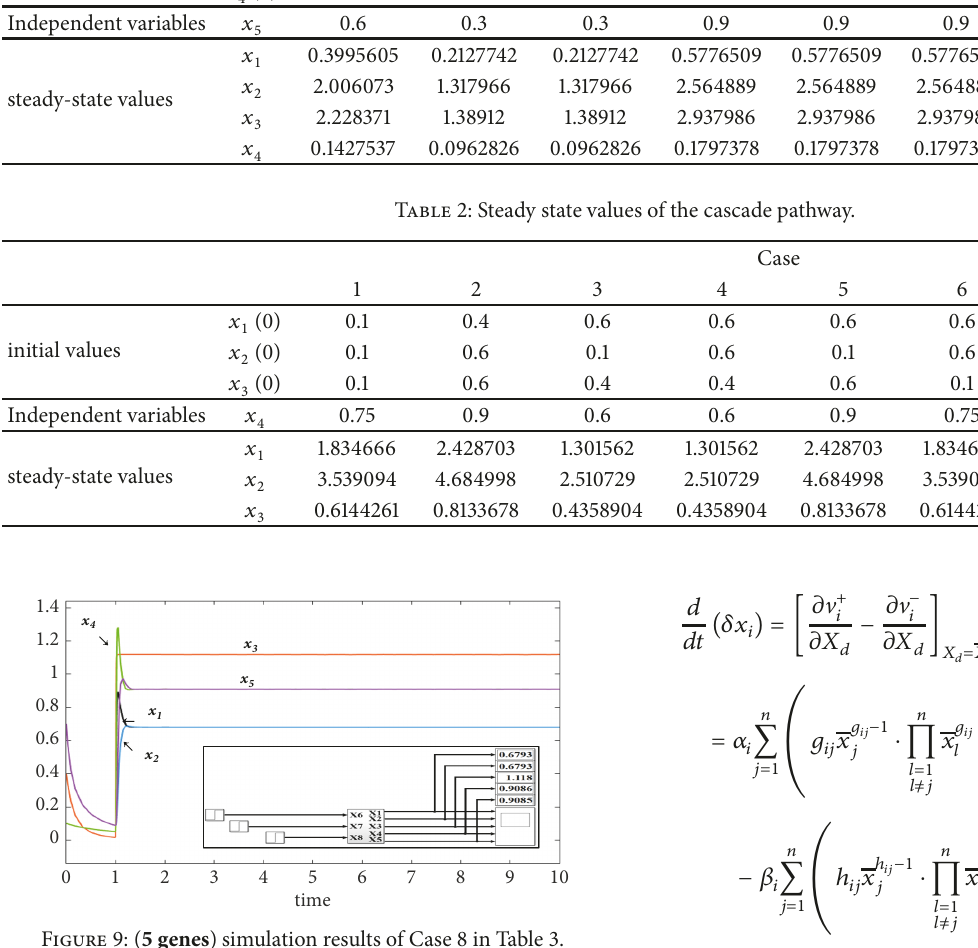
Figure 9: ( 5 g ene s ) simulation results of Case 8 in Table